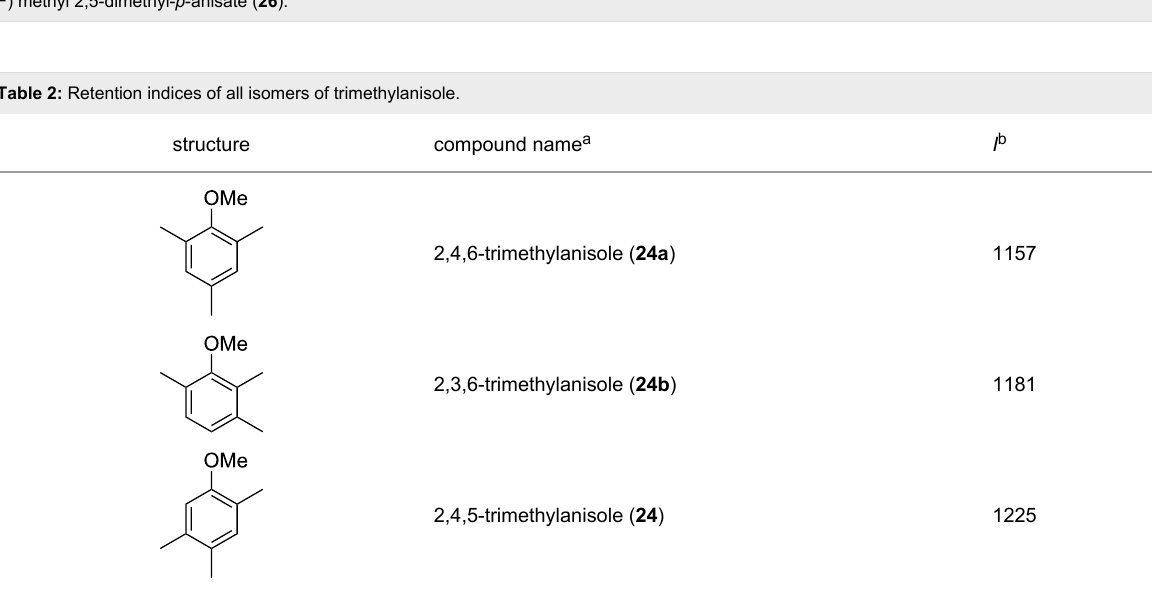
Figure 4: EI mass spectra of A) 2,4,5-trimethylanisole ( 24 ), B) the coeluting mixture of 3,4-dimethylanisole ( 23 ) and veratrole ( 20 ) with major peaks originating from 20 shown in red, C) the commercial standard of 23 , D) the commercial standard of 20 , E) 2,5-dimethyl- p -anisaldehyde ( 25 ), F) methyl 2,5-dimethyl- p -anisate ( 26 ).